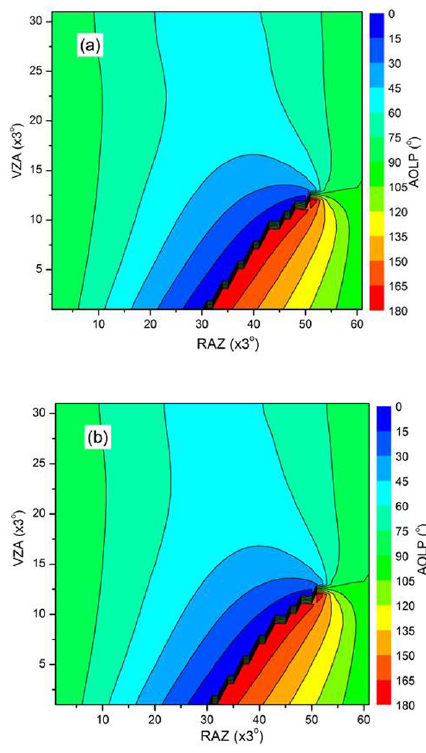
Fig. 13. Same as in Fig. 12, but for AOLPs from the pristine US standard (STD) atmosphere over the ocean (a) without wave shadow and (b) with wave